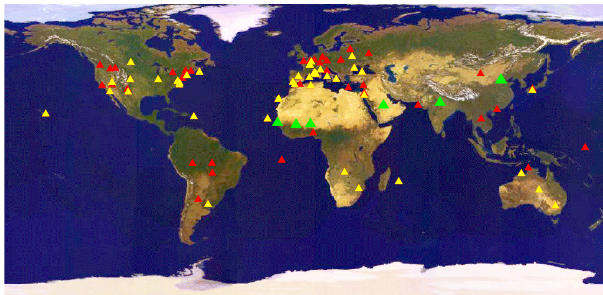
Figure 1. Locations of the stations selected for this study.